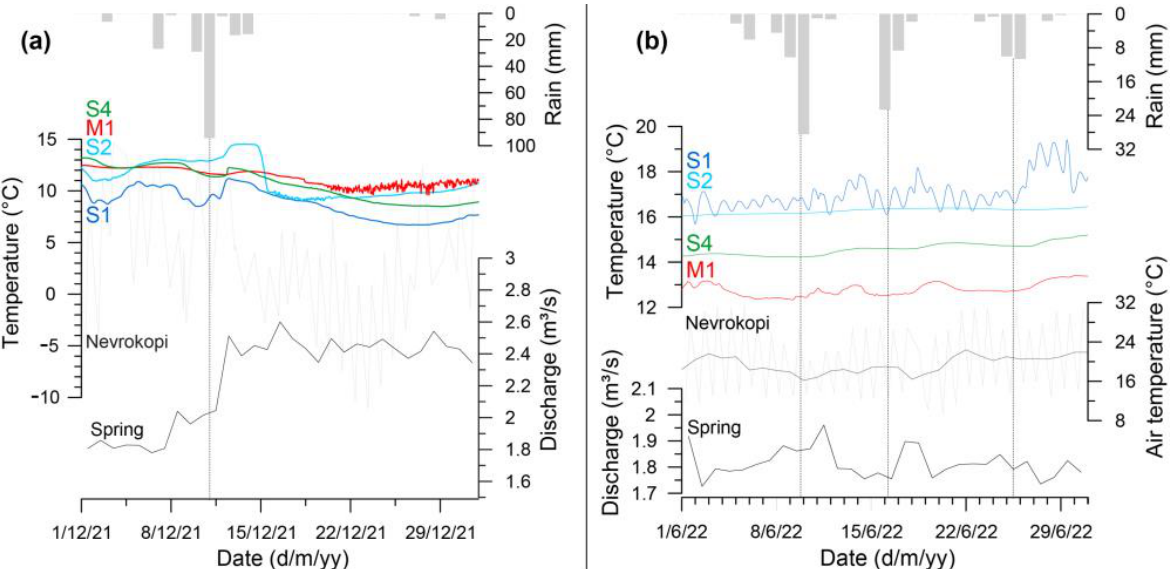
Figure 7. Intense rainfall in December 2021 ( a ) and June 2022 ( b ) and the corresponding flood hydrograph from the spring and related response in thermographs of the different monitoring stations.